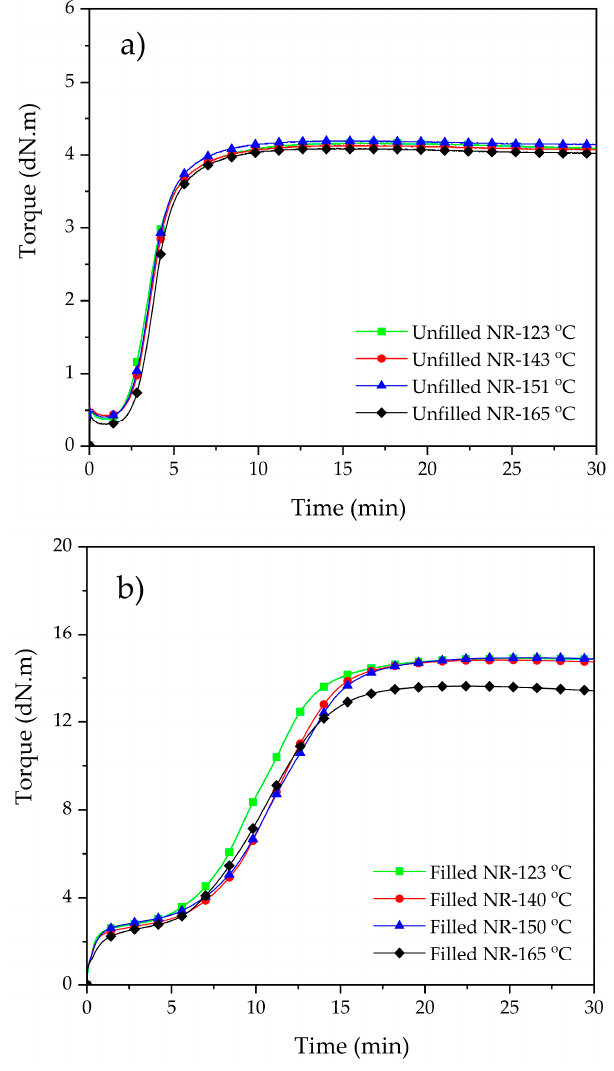
Figure 7. Cure characteristics of gum ( a ) and filled ( b ) NR compounds subjected to various dump temperatures.